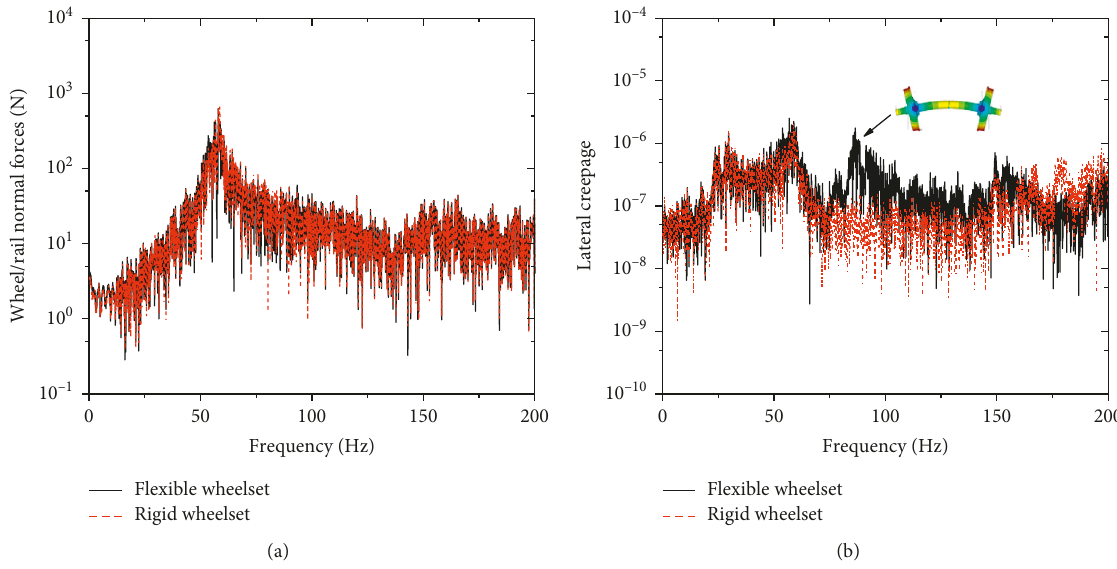
Figure 19: Comparison of the wheel/rail normal forces and creepage with and without wheelset